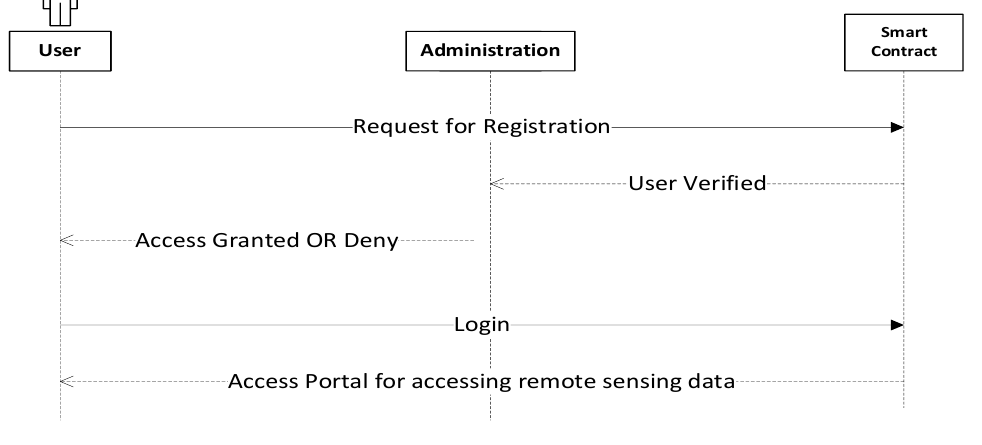
Figure 5. The registration process for a user.